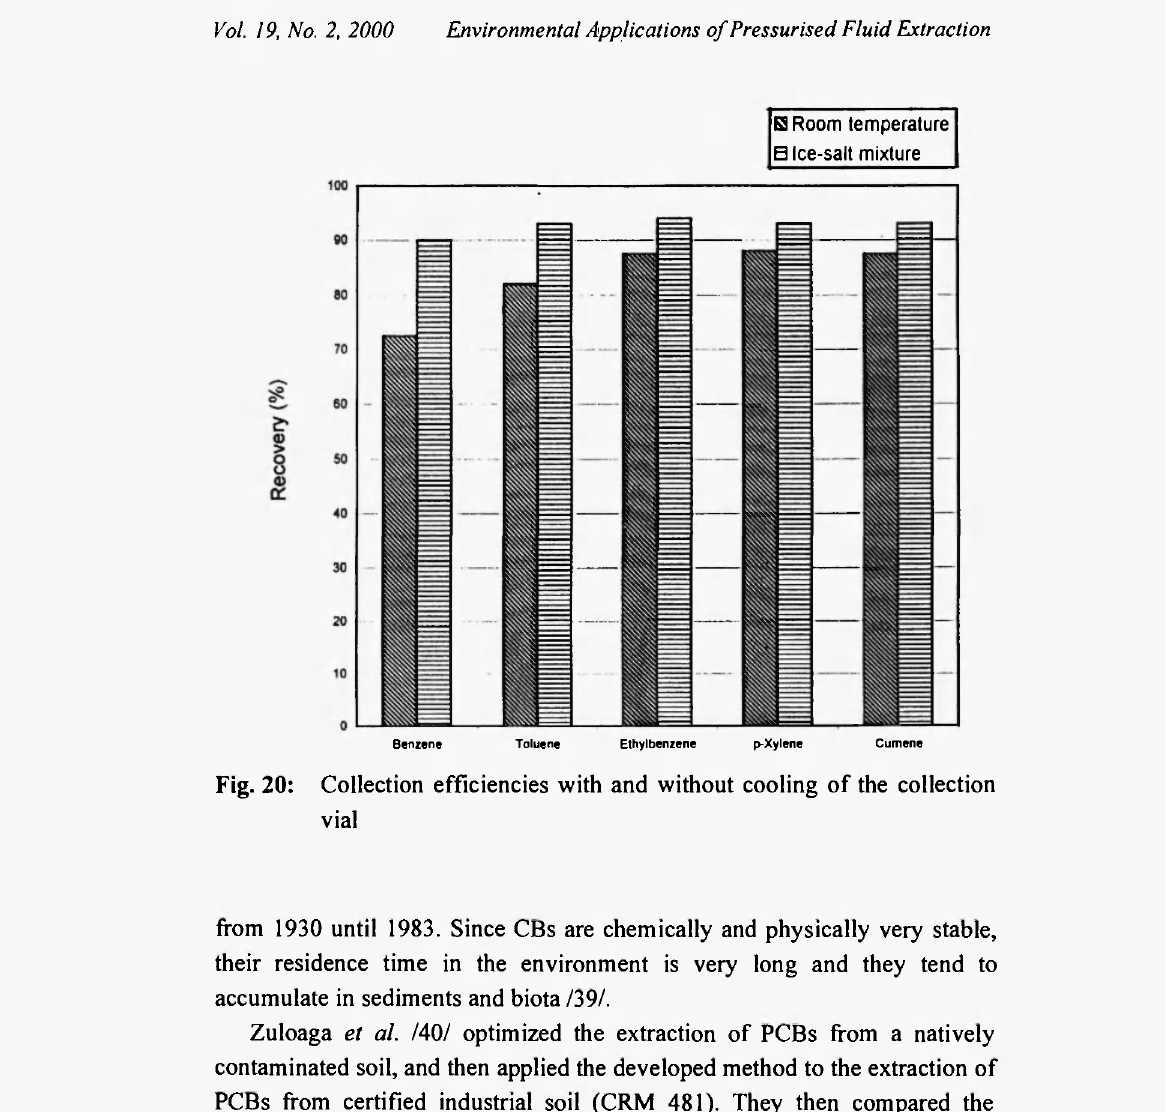
Fig. 20: Collection efficiencies with and without cooling of the collection